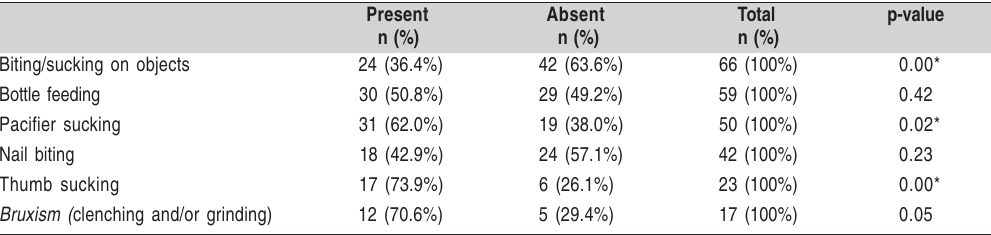
Table 2: Associations between mouth breathing and other harmful oral habits